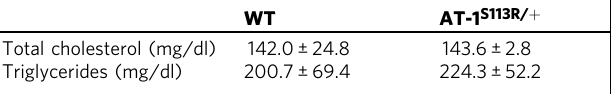
Table 2 Lipid serum pro fi le of WT and AT-1 S113R/ + mice fed standard diet WT